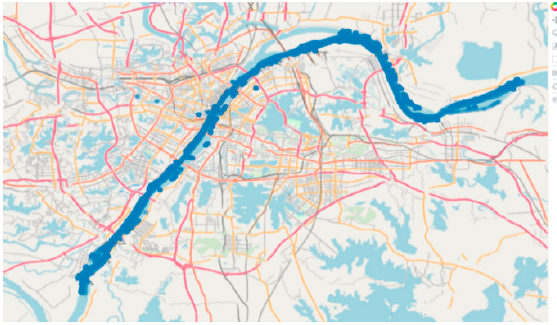
Figure 6. Geographical distribution of the trajectory in an open street map (OSM).